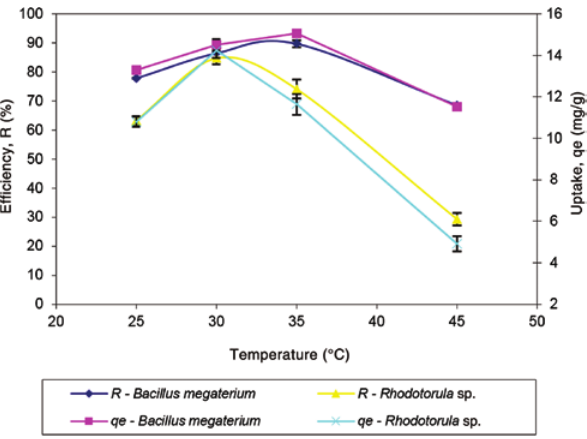
Figure 4: Influence of temperature on biosorption of Cd(II) ions by Rhodotorula sp. (pH 6, biomass dosage 5 g/l, contact time 48 h, initial Cd(II) concentration 50 mg/l) and B. megaterium (pH 4, biomass dosage 3 g/l, contact time 2 h, initial Cd(II) concentration 50